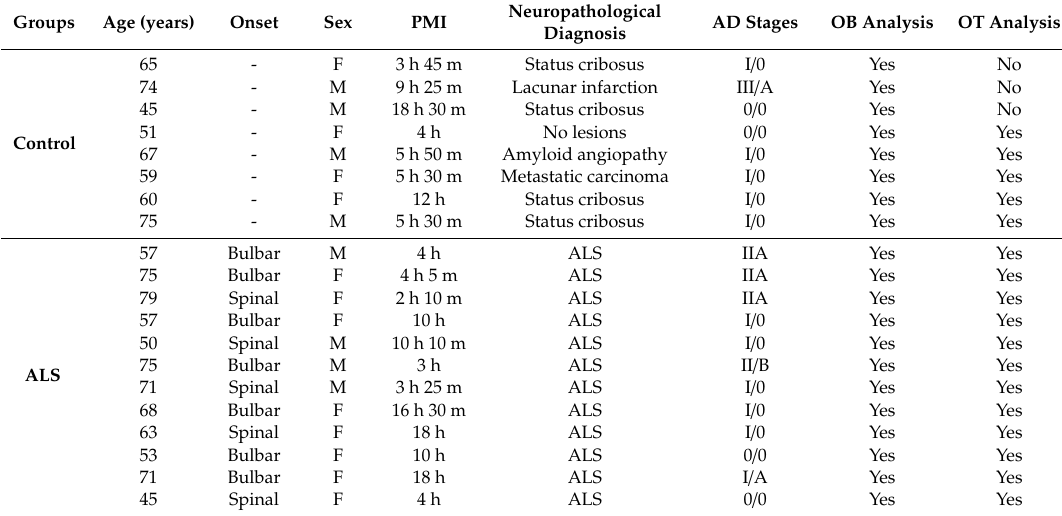
Table 2. Clinicopathological data of ALS subjects included in this